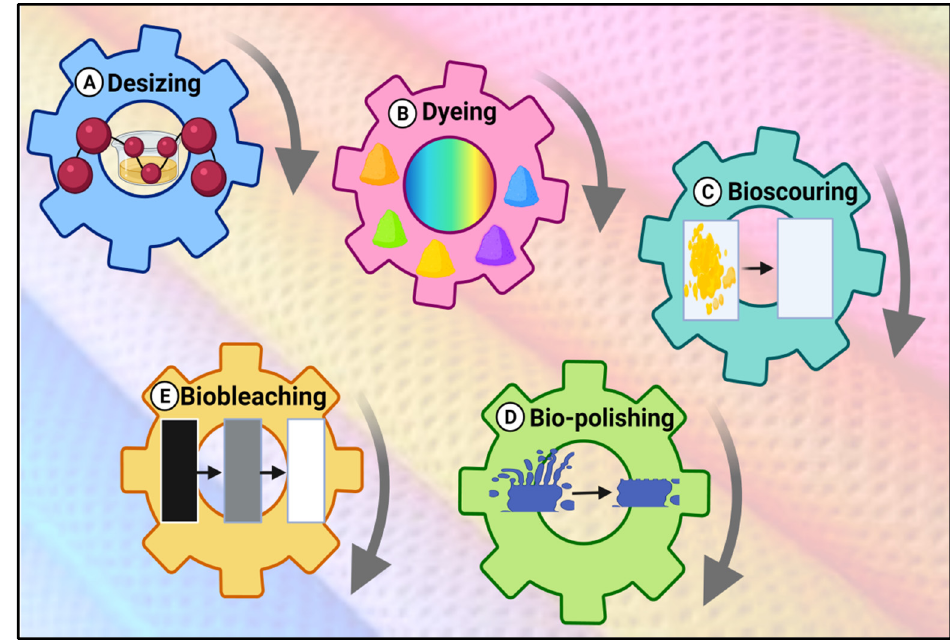
Figure 3. Fungal enzyme applications for textiles. ( A ) Desizing agents such as amylases; ( B ) dyeing and dye diffusers such as proteases; ( C ) textile processing and bioscouring of cotton fibers such as pectinases; ( D ) biofinishing and biopolishing such as cellulases; and ( E ) biobleaching and enzymatic rinse process after reactive dyeing such as peroxidases.